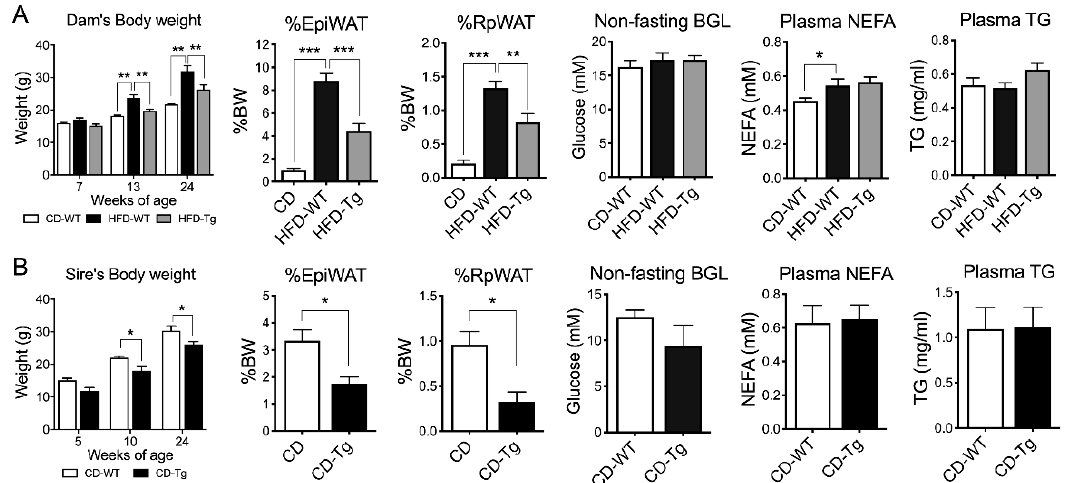
Figure 1. Body weight and fat mass of F0. ( A ) Dams ( n = 6–7). ( B ) sires ( n = 3–5). WT: